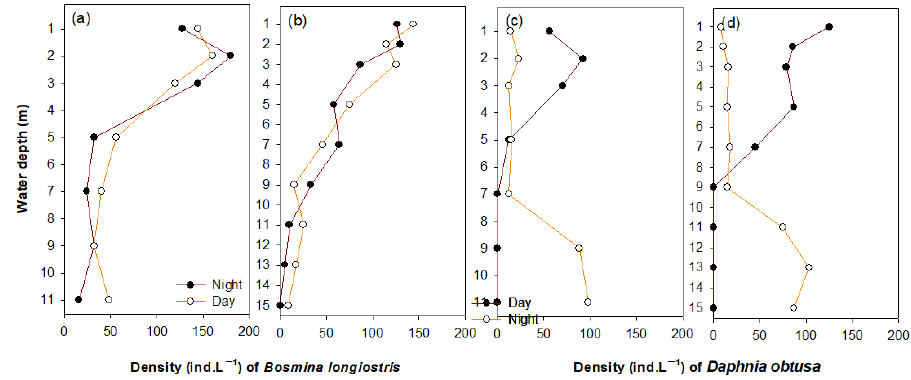
Figure 4. The vertical distribution (at intervals of 1–2 m) of Bosmina longirostris ( a , b ) and Daphnia obtusa ( c , d ) between day and night at sites 1 (a,c) and 3 (b,d).